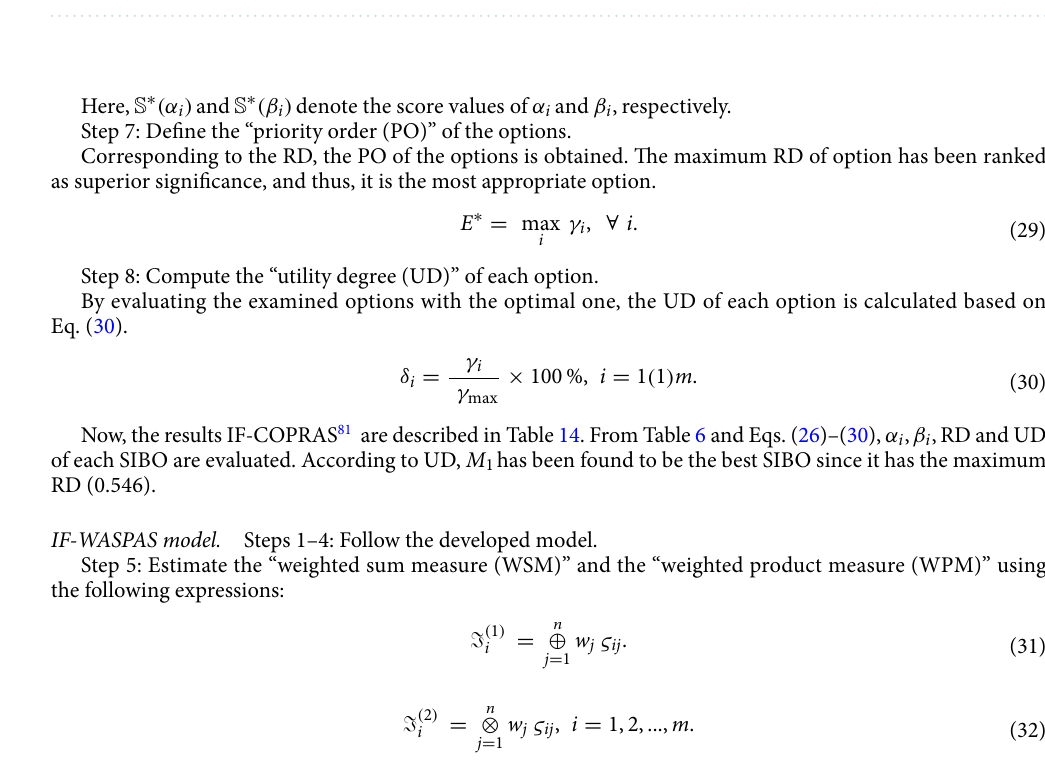
Table 7. The NA-IFDM for SIBOs